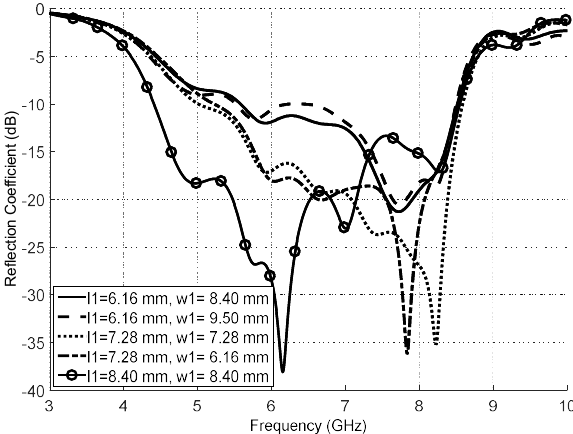
Figure 6. Predicted values of reflection coefficient (S11) with five different parasitic patch sizes.